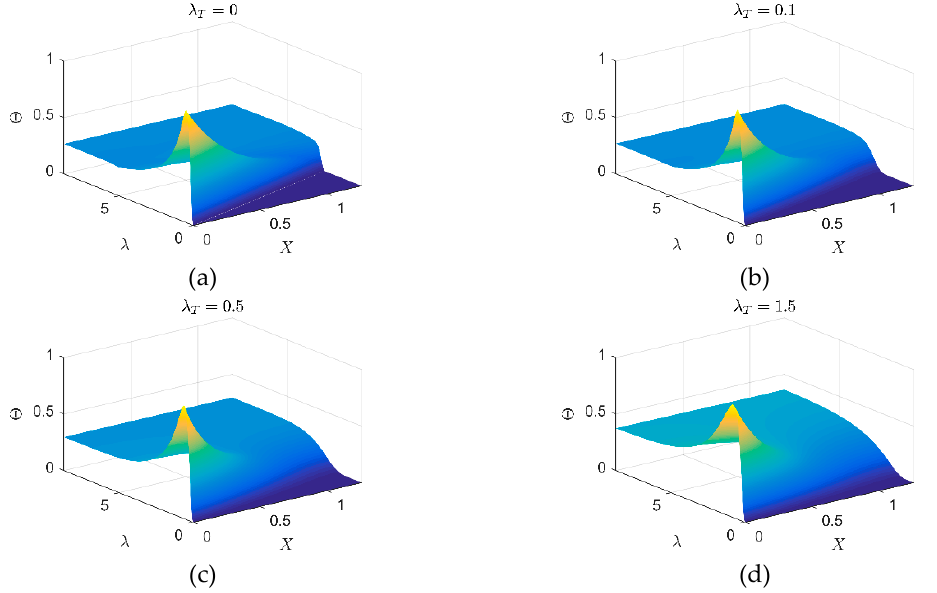
Figure 2. Thermal wave propagation in one-dimensional media: ( a ) λ T = 0; ( b ) λ T = 0.1; ( c ) λ T = 0.5; ( d ) λ T =